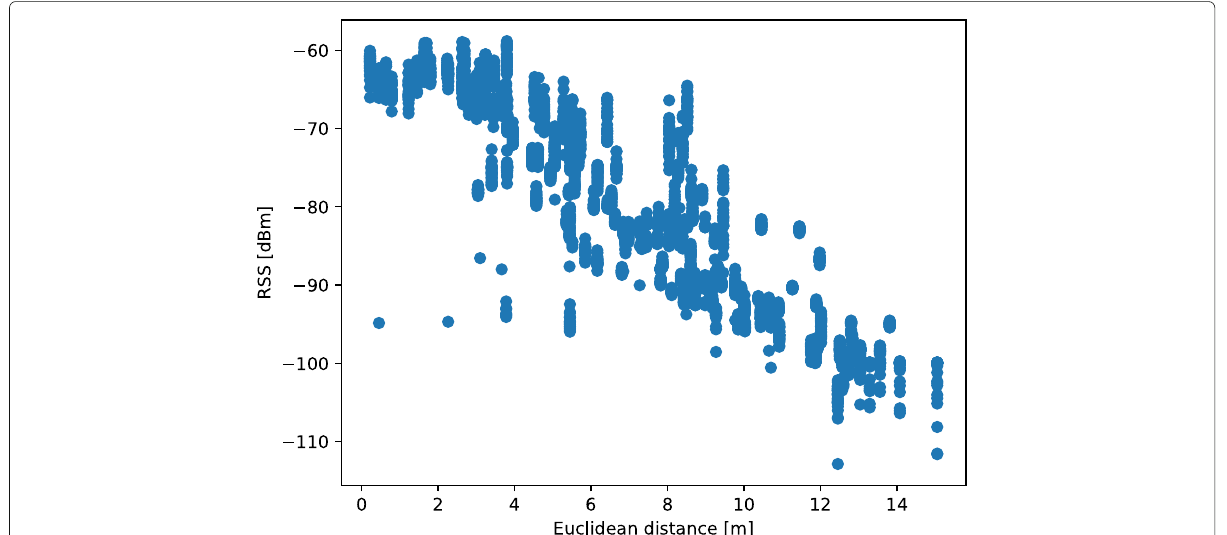
Fig. 5 Graphical representation of measured RSSI values at different anchor distances in the reference indoor environment